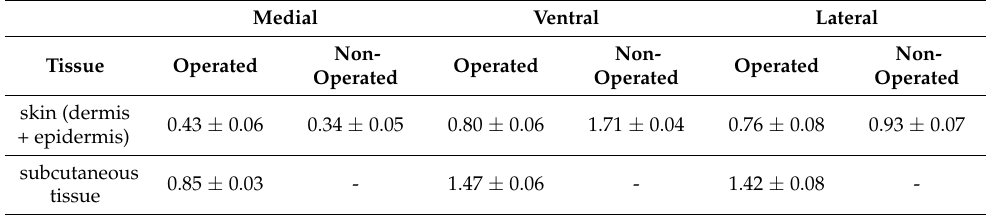
Table 2. Thickness (mm) of tissues surrounding the medial, ventral, and lateral aspects of either the endoprosthetic (operated) or biological (non-operated) foot in rabbit E1 (n = 1). Each value (mean ± standard deviation) was computed from 8 to 13 measurements from a single histology